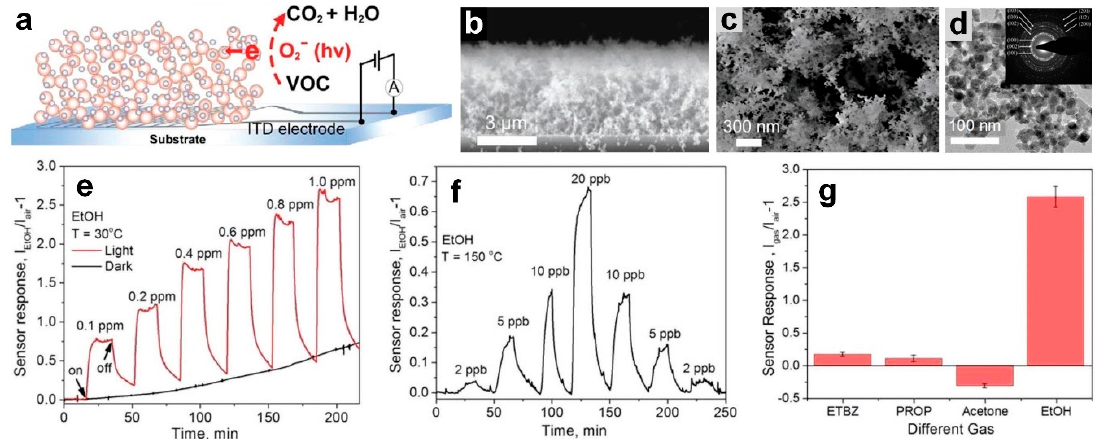
Figure 14. ( a ) Schematic representation and ( b , c ) SEM images of the p–n NiO–ZnO nanoheterojunctions devices for chemoresistive sensing of VOC. ( d ) TEM image of the fabricated NiO-ZnO nanoparticles with inset SAED pattern. ( e ) Dynamic responses of 1 nm NiO–6 µm ZnO nanoheterojunction film to ethanol molecules as a function of its concentration from 0.1 to 1 ppm at room temperature in dark or under solar irradiation. ( f ) Dynamic responses of a 1 nm NiO–ZnO film to ethanol with concentrations from 2 to 20 ppb at 150 °C under solar irradiation. ( g ) Sensor response of a 1 nm NiO–ZnO film to 1 ppm of ethylbenzene, propane, acetone, and ethanol at 30 °C under solar irradiation [15].